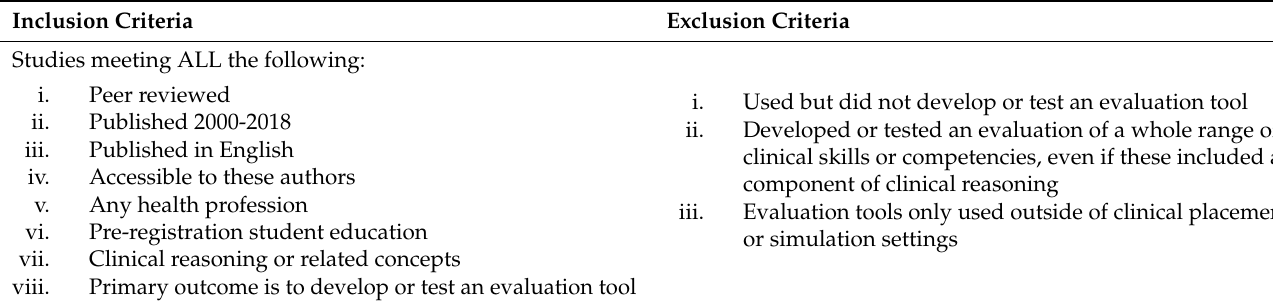
Table 1. Inclusion and exclusion